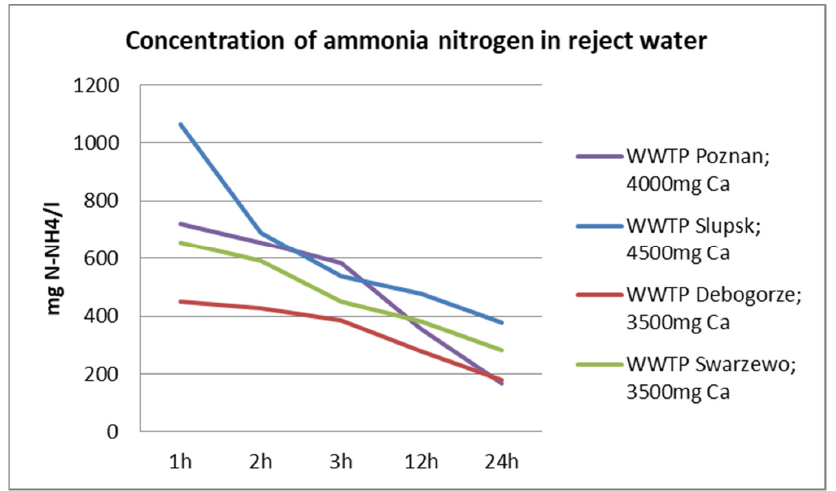
Figure 6. Changes in N-NH 4 concentrations in reject water during a series of 24-h tests for 4 WWTPs. It is noteworthy that a very high phosphorus removal efficiency of 99.9% was ob- tained for all tested reject water. This indicates that, despite the observed differences in